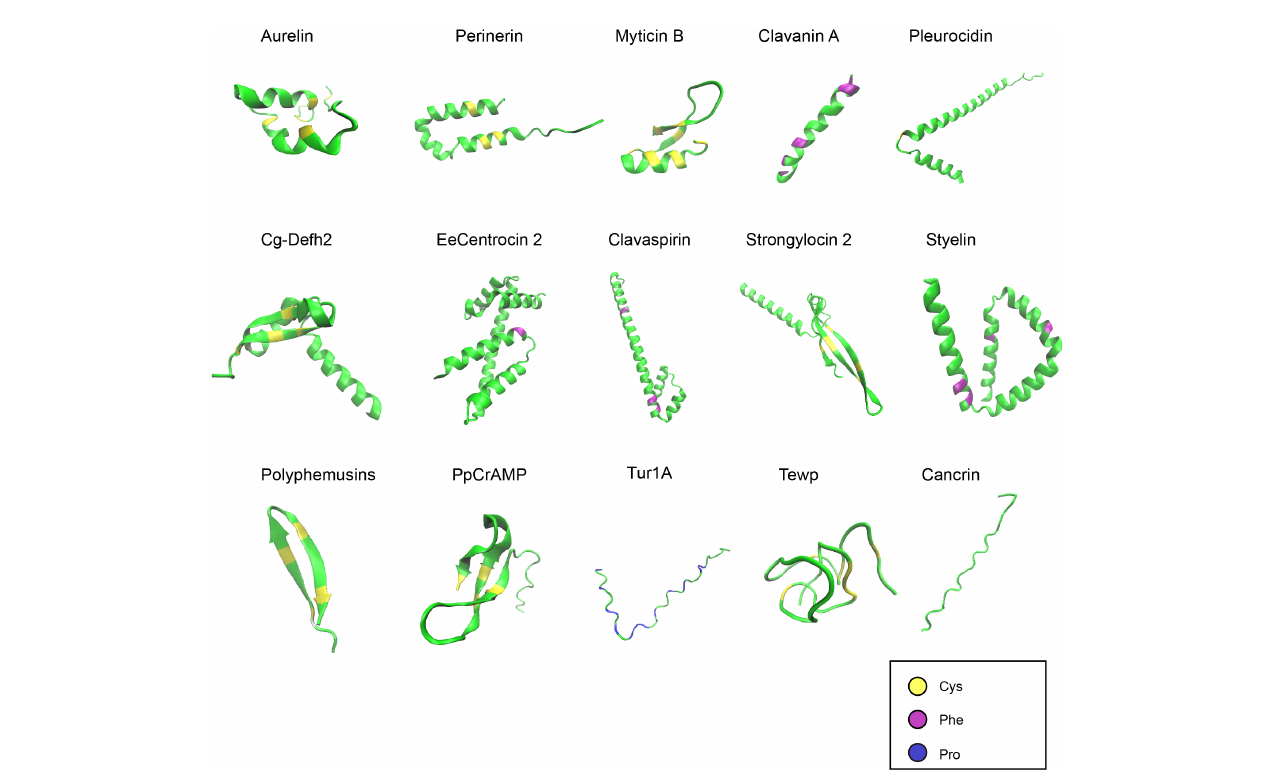
FIGURE 2 Structures of representative marine AMPs. The AMPs demonstrated are from different taxa of marine animals. The peptide structures were predicted by AlphaFold and shown in green. Cysteines, phenylalanines, and prolines are highlighted in yellow, purple, and blue,